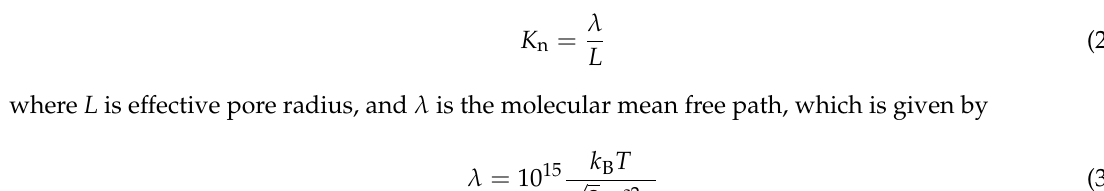
Figure 4. The pore distributions curves of Longmaxi formation Sichuan basin.